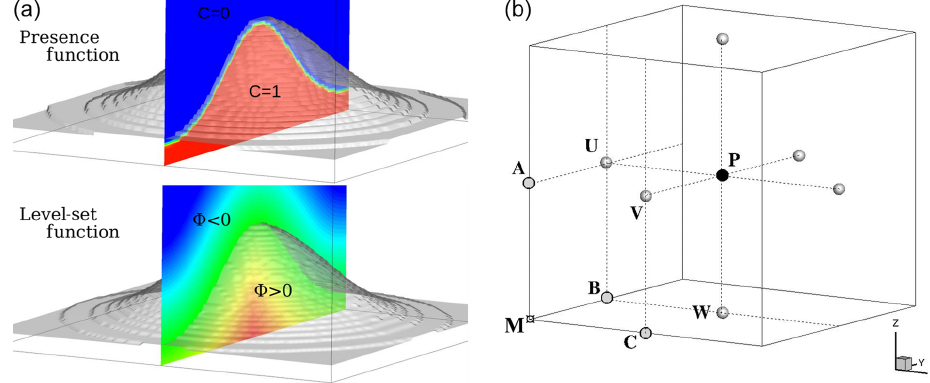
Figure 1. (a) Illustration of two ways to model a fluid–solid interface: the color code indicates the isocontours of the presence function C and the level-set function φ . (b) Definition of the point types per cell: M is the geometric mesh point, P the mass point, U,V,W the velocity nodes, and A, B, C the vorticity